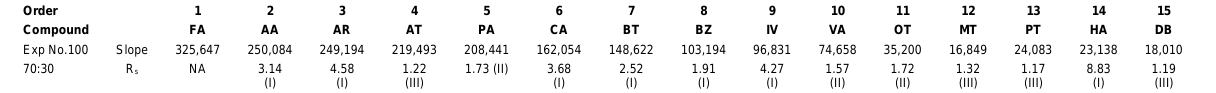
Results of all R Values for All Experiments Conducted in Experiment Stage 2 (Ternary Mobile s